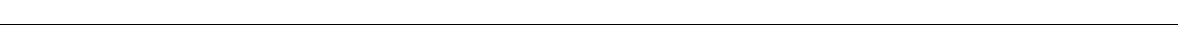
Fig. 1 Modular organization of dynamic splicing switches during cortex development. a The number of non-redundant cassette exons with differential splicing (| ΔΨ | ≥ 0.2, Benjamini FDR ≤ 0.05) in each pairwise comparison of developmental stages. The numbers of exons with increased inclusion at later stages are shown above the diagonal (top right), and exons with decreased inclusion at later stages are shown below the diagonal (bottom left). b Mouse cassette exons with developmental changes are highly conserved in human, as measured by the percentage of exons with conserved splicing in human (left) or the percentage of exons under strong evolutionary selection pressure (right). c An example of developmental splicing regulation in exon 8a of the Kdm1a gene. Inclusion of this microexon peaks between postnatal days P0 – P7. d Four modules of developmentally regulated exons identi fi ed by WGCNA analysis with distinct temporal patterns during cortex development. A non-redundant set of 2883 known and novel cassette exons was included for this analysis, and their mean-substracted inclusion levels across developmental stages are shown in the heatmap. Exons in each module were ranked based on their correlation with the eigenvector of the module, and those with the strongest correlation are de fi ned as core members (black bars on the right). Exons in each module are further divided into two groups (e.g., M1 + and M1 − ) depending on positive or negative correlation with the eigenvector. e Enrichment of gene ontology (GO) terms in exons showing splicing switches with speci fi c timing. The timing of developmental splicing switches is parameterized by sigmoidal curve fi tting, and exons are ranked based on the timing. Exons in each sliding window (with a window size of 300 exons) were compared to all cassette exons with suf fi cient read coverage in the brain to identify signi fi cant GO terms. Only GO terms signi fi cant in at least one sliding window are shown (Benjamini FDR ≤ 0.05). Broad categories and top GO terms in each category are highlighted on the